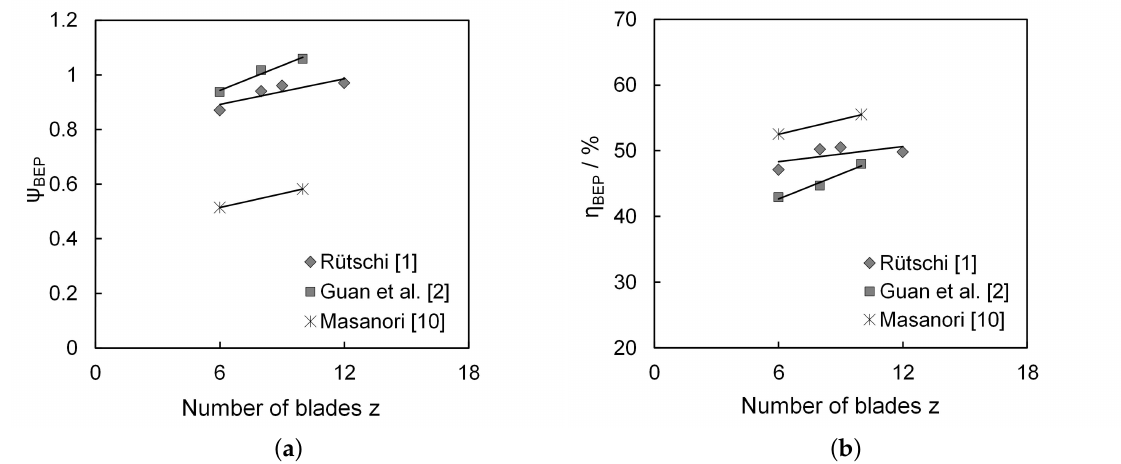
Figure 12. ( a ) Pressure coefficient over number of blades; and ( b ) efficiency over number of blades.